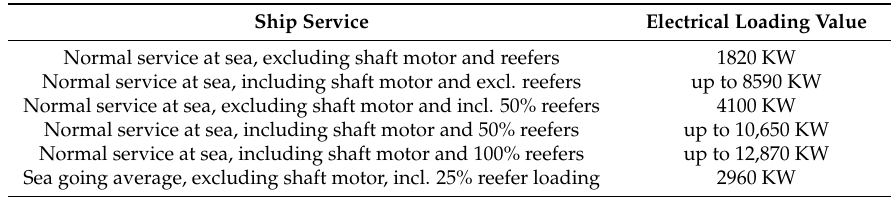
Figure 3. Load profile of a typical Post Panamax container ship. ME refers to Main Engine and CSR refers to Continuous Service Rating. Table 2. Hotel loading of Post Panamax ship at sea.